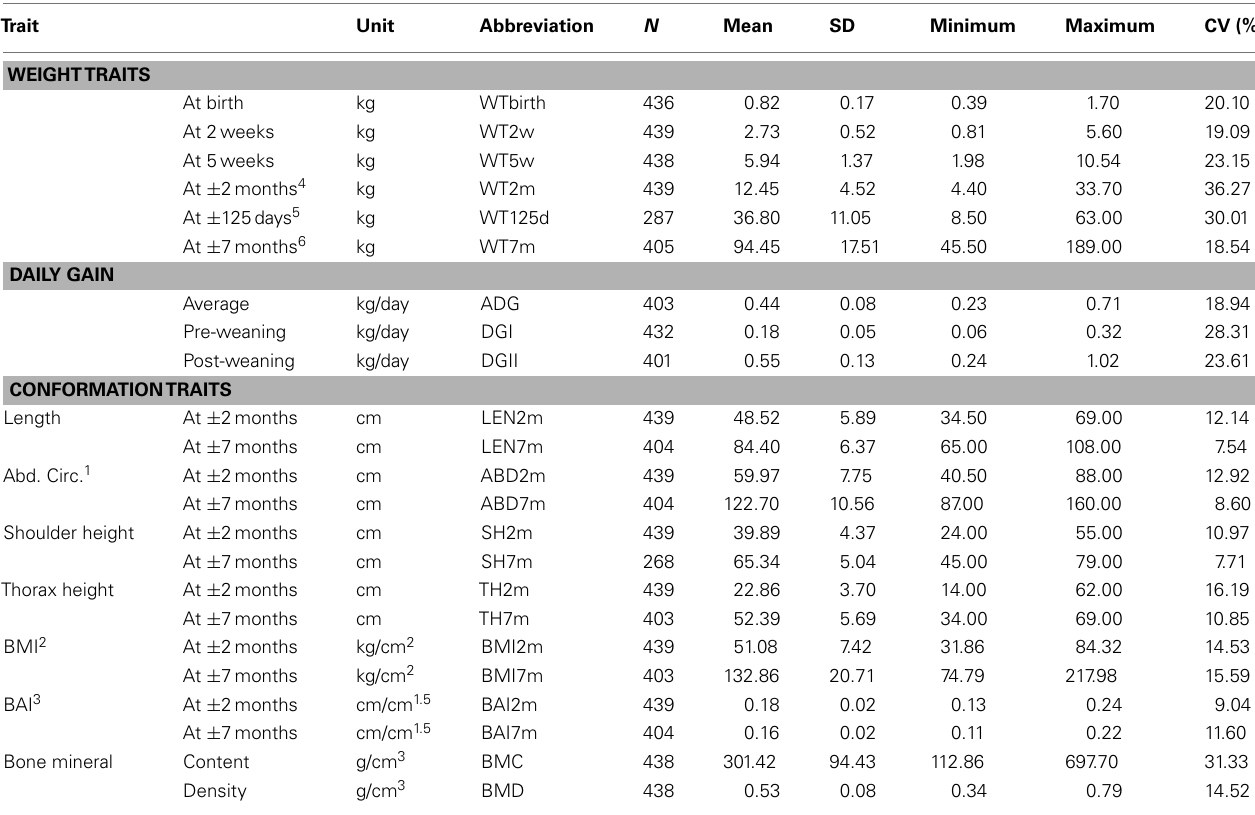
Table 2 | Summary of all traits indirectly associated with obesity and obesity-related traits (mean, range, and SD) with their